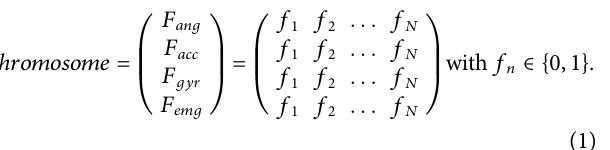
FIGURE 1 | Measurement setup of the MyPredict dataset, with the ramps and